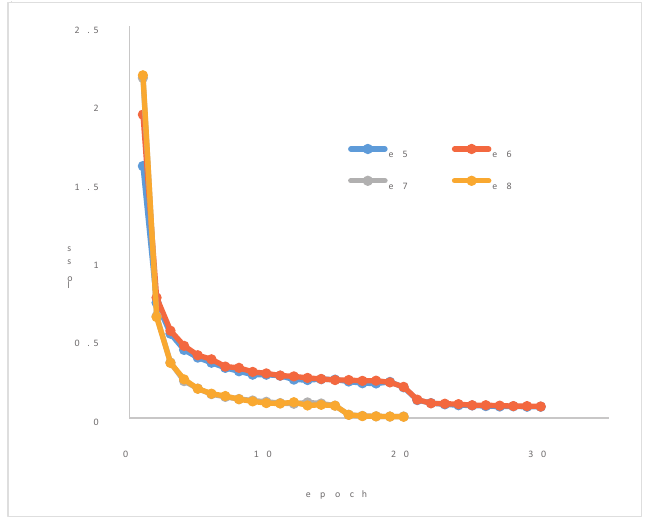
Figure 5. The loss in the spatial domain and frequency domain in the pre-training